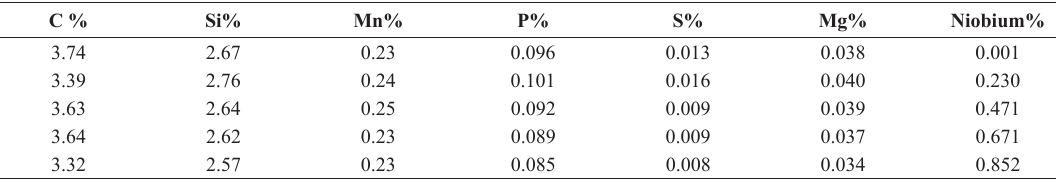
Table 1. Chemical composition of the NCIs